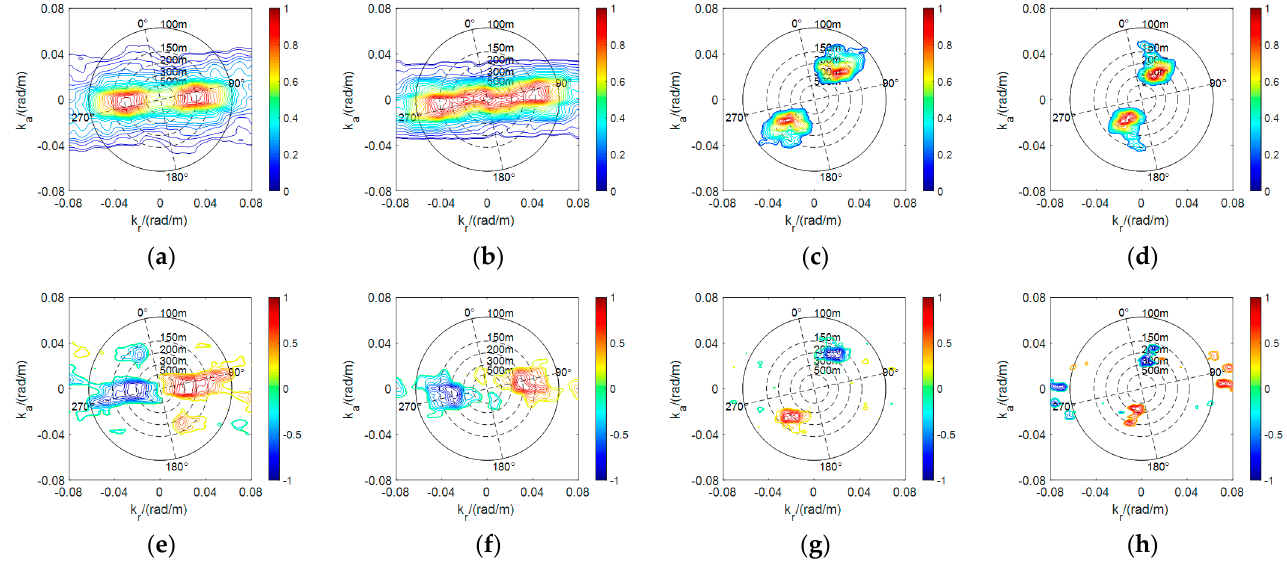
Figure 9. The cross-spectra of the TerraSAR-X images in A 1 , A 2 , A 3 , and A 4 : ( a – d ) the real parts of the TerraSAR-X images cross-spectra in A 1 , A 2 , A 3 , and A 4 , respectively; ( e – h ) the imaginary parts of the TerraSAR-X image cross-spectra in A 1 , A 2 , A 3 , and A 4 , respectively. According to the sea surface profiles in A 1 , A 2 , A 3 , and A 4 , and combined with the